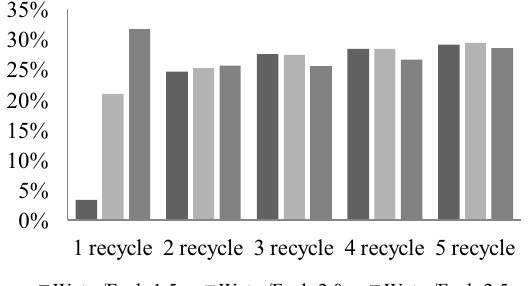
Fig. 2. Natural uranium consumption reduction for each FA concepts during multiple recycle.